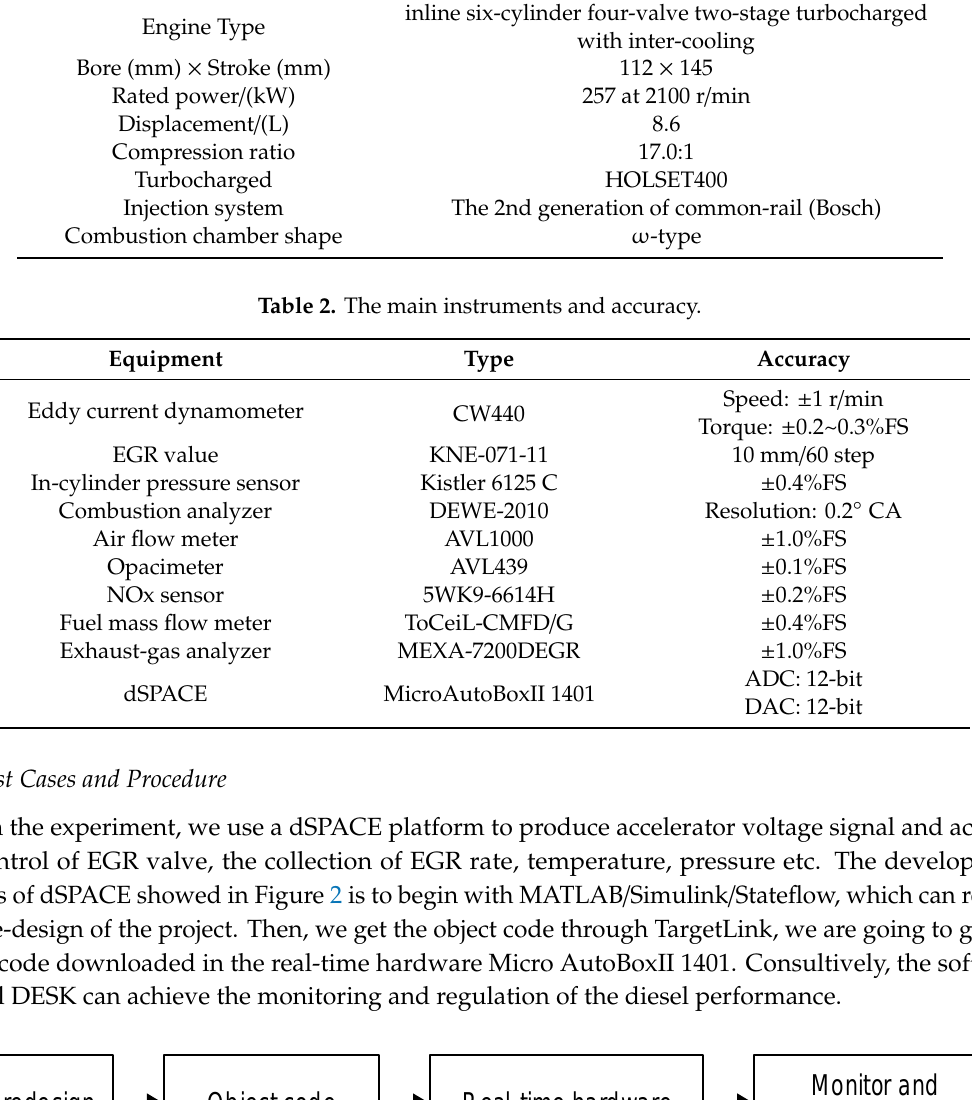
Table 1. Specifications of the basic engine.